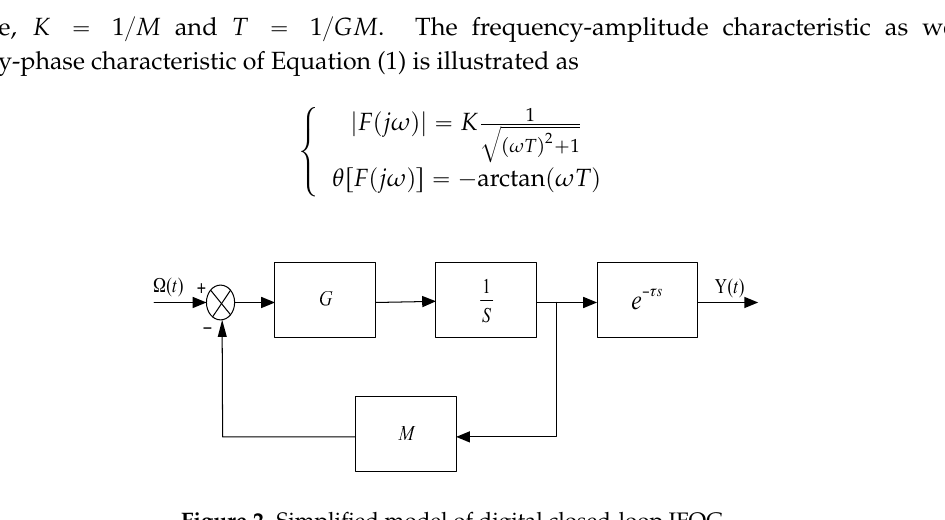
Figure 2. Simplified model of digital closed-loop IFOG.